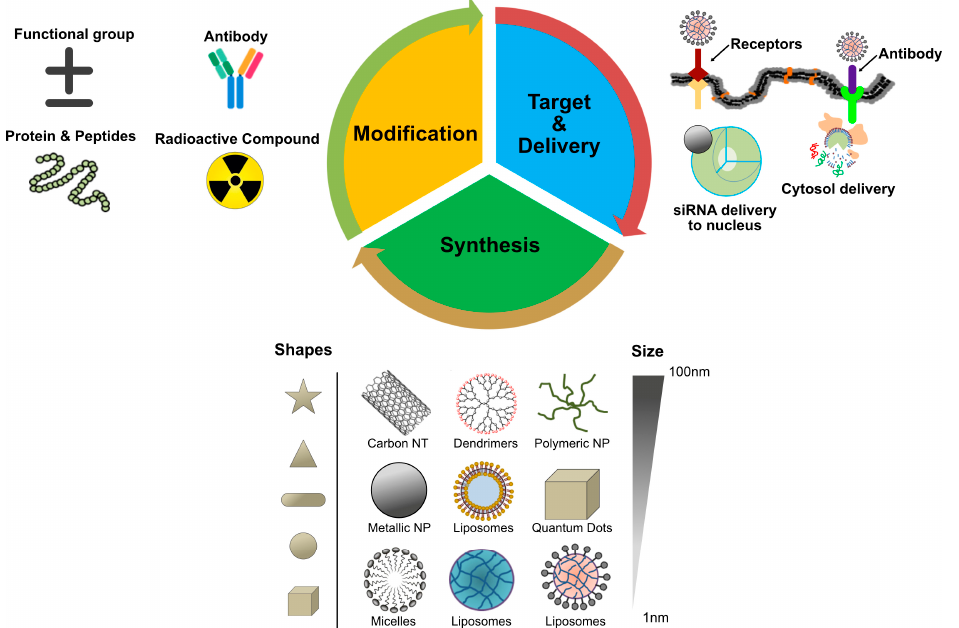
Figure 3. Central dogma of nanoparticles targeting in cancer cells.